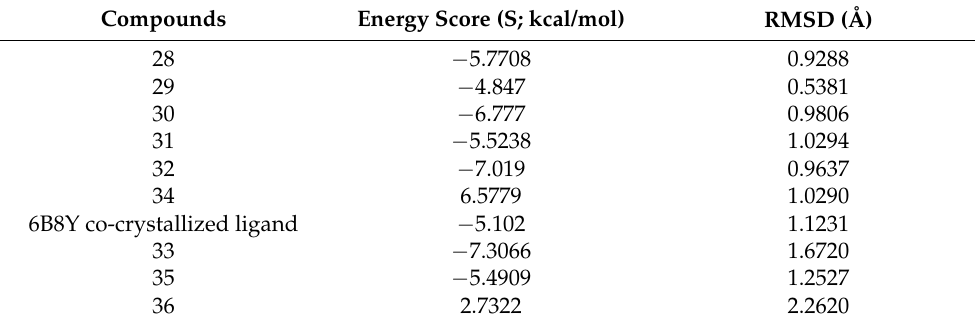
Table 4. Interaction binding energy (S; kcal/mol) as well as (RMSD; A) binding accuracy of isolated compounds from V. vinifera seeds and co-crystallized ligand within TGFBR1 kinase (PDB ID: 6B8Y). Compounds Energy Score (S;